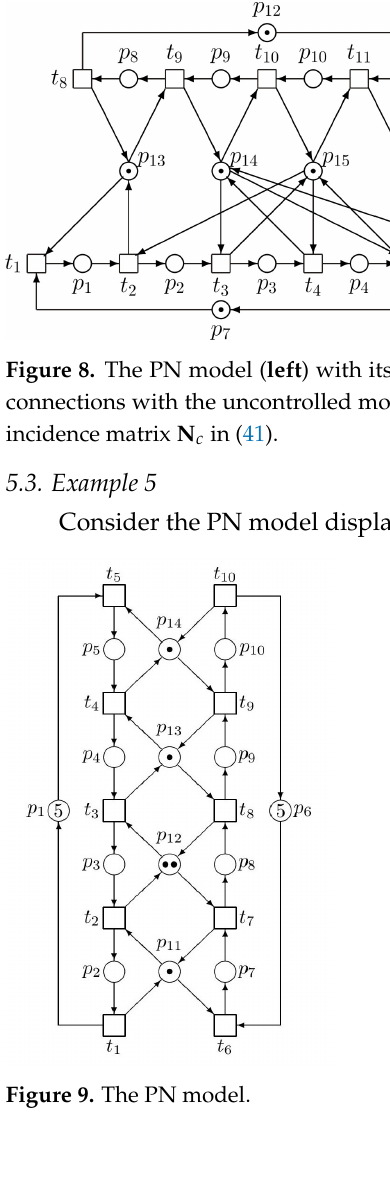
Figure 9. The PN